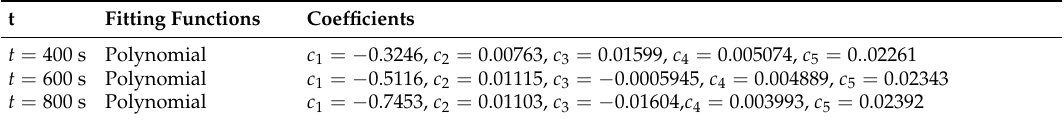
Table 4. Coefficients in Fitting Functions of normalized Doppler shift γ DIF (Rising).